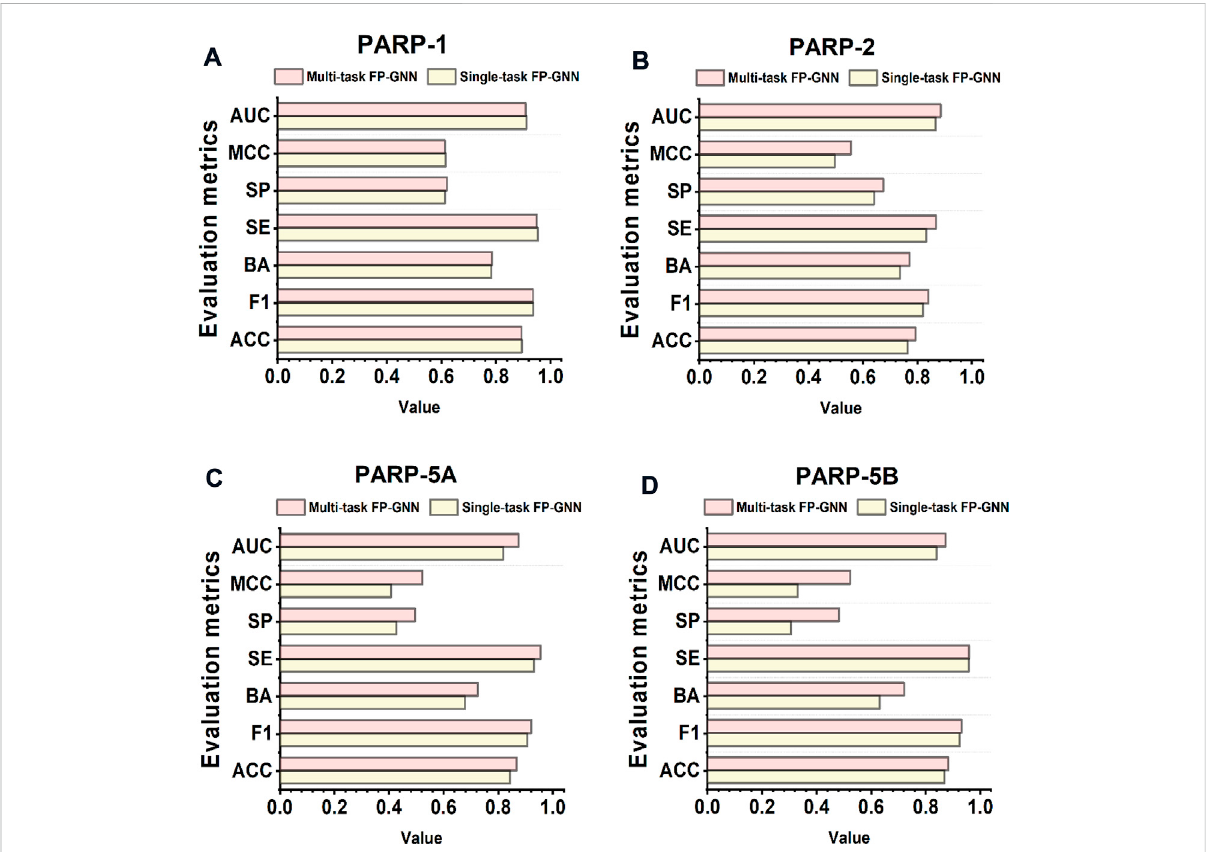
FIGURE 6 Performanceof single-task FP-GNN and multi-task FP-GNN models on the test sets of PARP-1 (A) , PARP-2 (B) , PARP-5A (C) , and PARP-5B (D) .